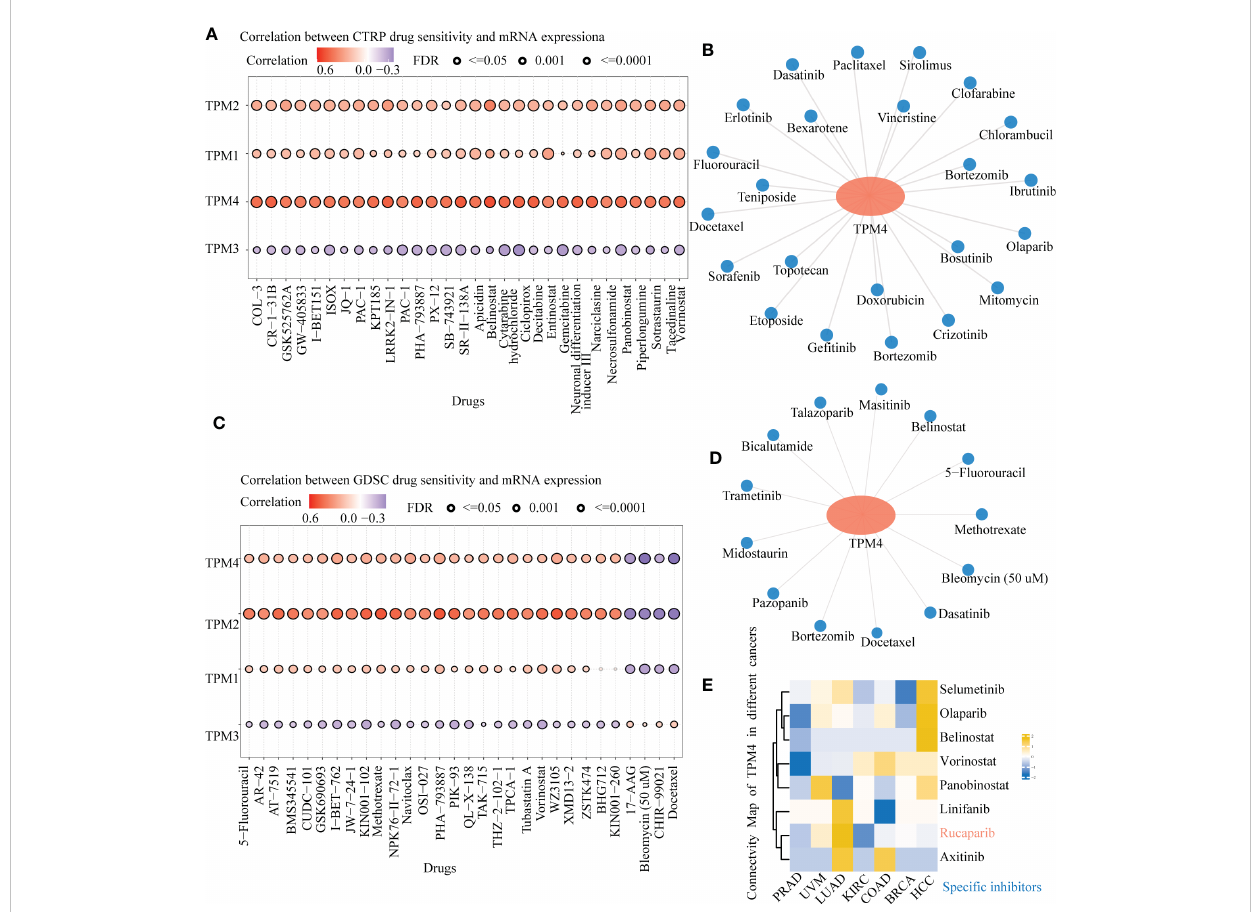
FIGURE 9 Drug sensitivity of TPM4-related drugs in pan-cancer tissues. (A) . Relationship between CTRP drug sensitivity and mRNA expression of TPM1, TPM2, TPM3, and TPM4. (B) FDA-approved TPM4-related chemotherapeutic drugs from CTRP drug sensitivity (C) . Correlation between GDSC drug sensitivity and mRNA expression of TPM1, TPM2, TPM3, and TPM4. (D) FDA-approved TPM4-related anti-cancer drugs from GDSC drug sensitivity. (E) Heatmap of small molecules drugs targeting in TPM4 from Connective